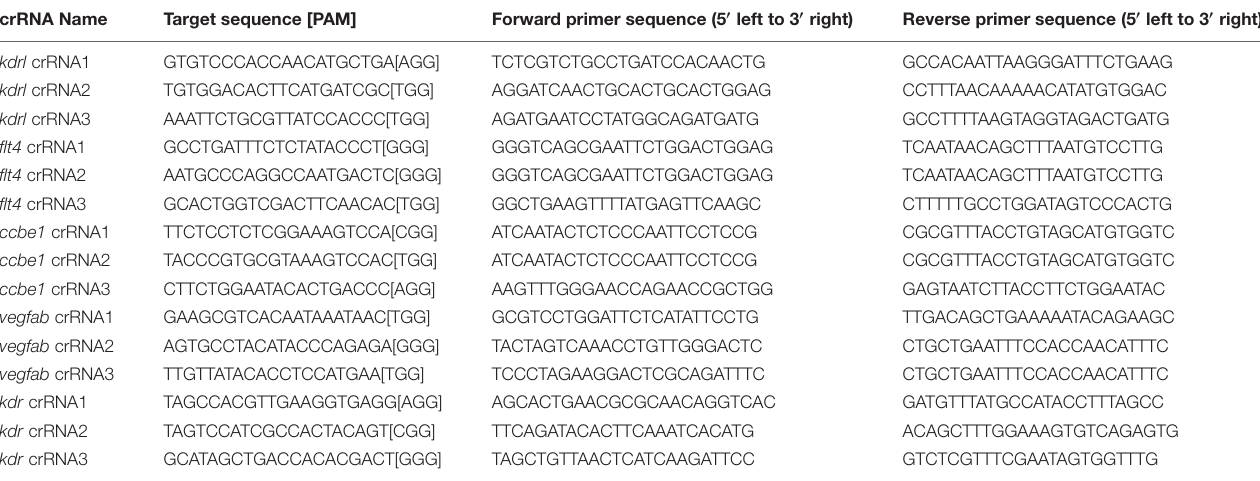
TABLE 3 | PCR primer pairs used to amplify genomic fragments containing crRNA target sequences within the genome of zebrafish